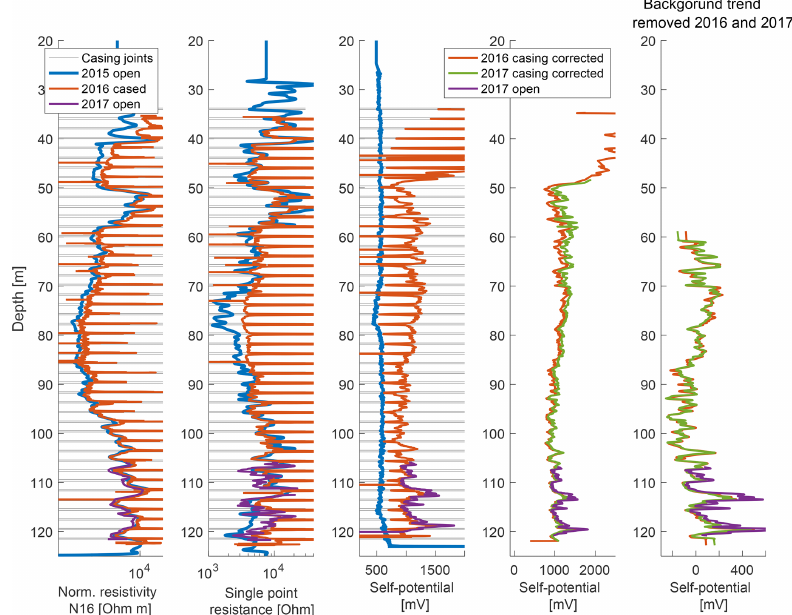
Figure B1. Comparison of open- and cased-hole data. From left to right: normal resistivity, single-point resistance, and SP logs for 2015, 2016, and 2017 with casing joints marked in grey, casing-corrected SP log, and background-trend-corrected SP log.